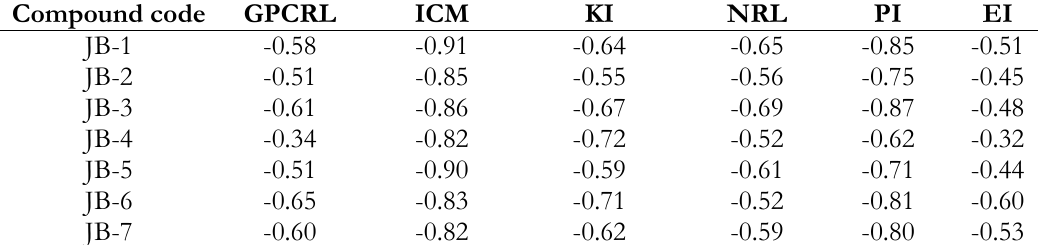
Table III. Bioactivity score of Azomethines Compound